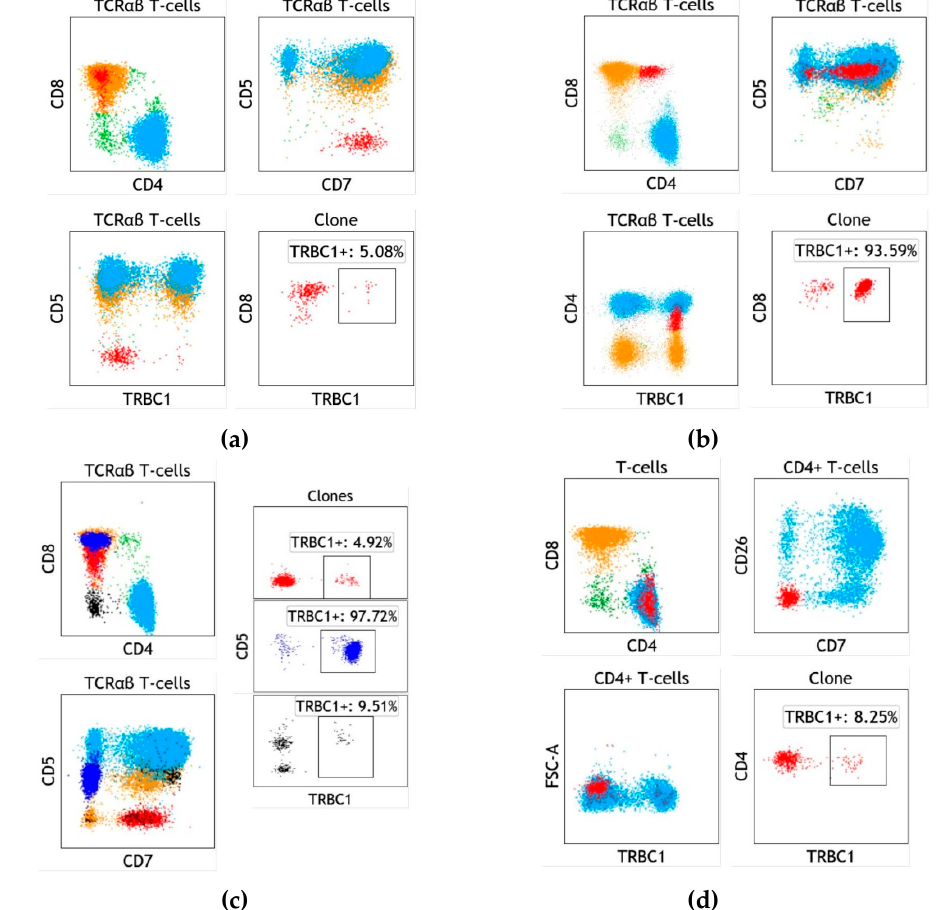
Figure 2. T-cell clones of uncertain significance (T-CUS), detected in patients with no clinical evidence of T-cell malignancy. ( a ) Typical CD8-positive T-CUS (red) detected in a bone marrow aspirate from a patient with splenic marginal zone lymphoma. The clone is relatively small in size, TRBC1-negative, and easily identifiable on a CD5 vs. CD7 dot plot. ( b ) CD4/CD8 double-positive T-CUS (red) in a peripheral blood specimen from a patient status post-renal transplant. This variant frequently exhibits dim CD4 or CD8 expression. The clonal T cells are TRBC1-positive. ( c ) Multiple T-CUS identified in a peripheral blood specimen from a patient with inclusion body myositis and normal blood counts. Two dominant CD8-positive clones (red and blue) are identified on a CD5 vs. CD7 dot plot, one positive and another negative for TRBC1. A third small CD4/CD8 double negative T-CUS lacking TRBC1 expression (black) is also detected. ( d ) A CD4-positive T-CUS (red) is detected in a blood specimen from a patient with metastatic squamous cell carcinoma and chronic lymphocytic leukemia. These rare and small clonal subsets are frequently negative for CD7 and CD26 and often cluster within the higher normal range for light scatter. In addition, shown are polytypic CD4-positive (cyan) and CD8-positive (orange) T cells and other non-gated events (green). T cells were gated based on CD3 expression, and TCR αβ T cells were gated by the exclusion of TCR γδ positivity. FSC-A: Forward light scatter amplitude.